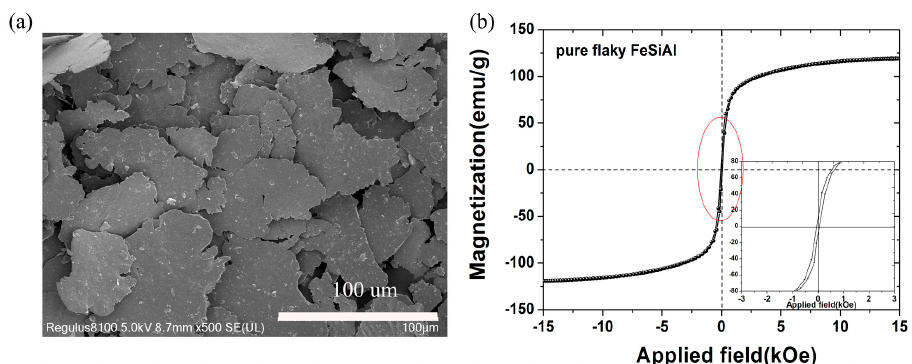
Figure 2. ( a ) SEM micrographs and ( b ) magnetic hysteresis loop of the pure FeSiAl.